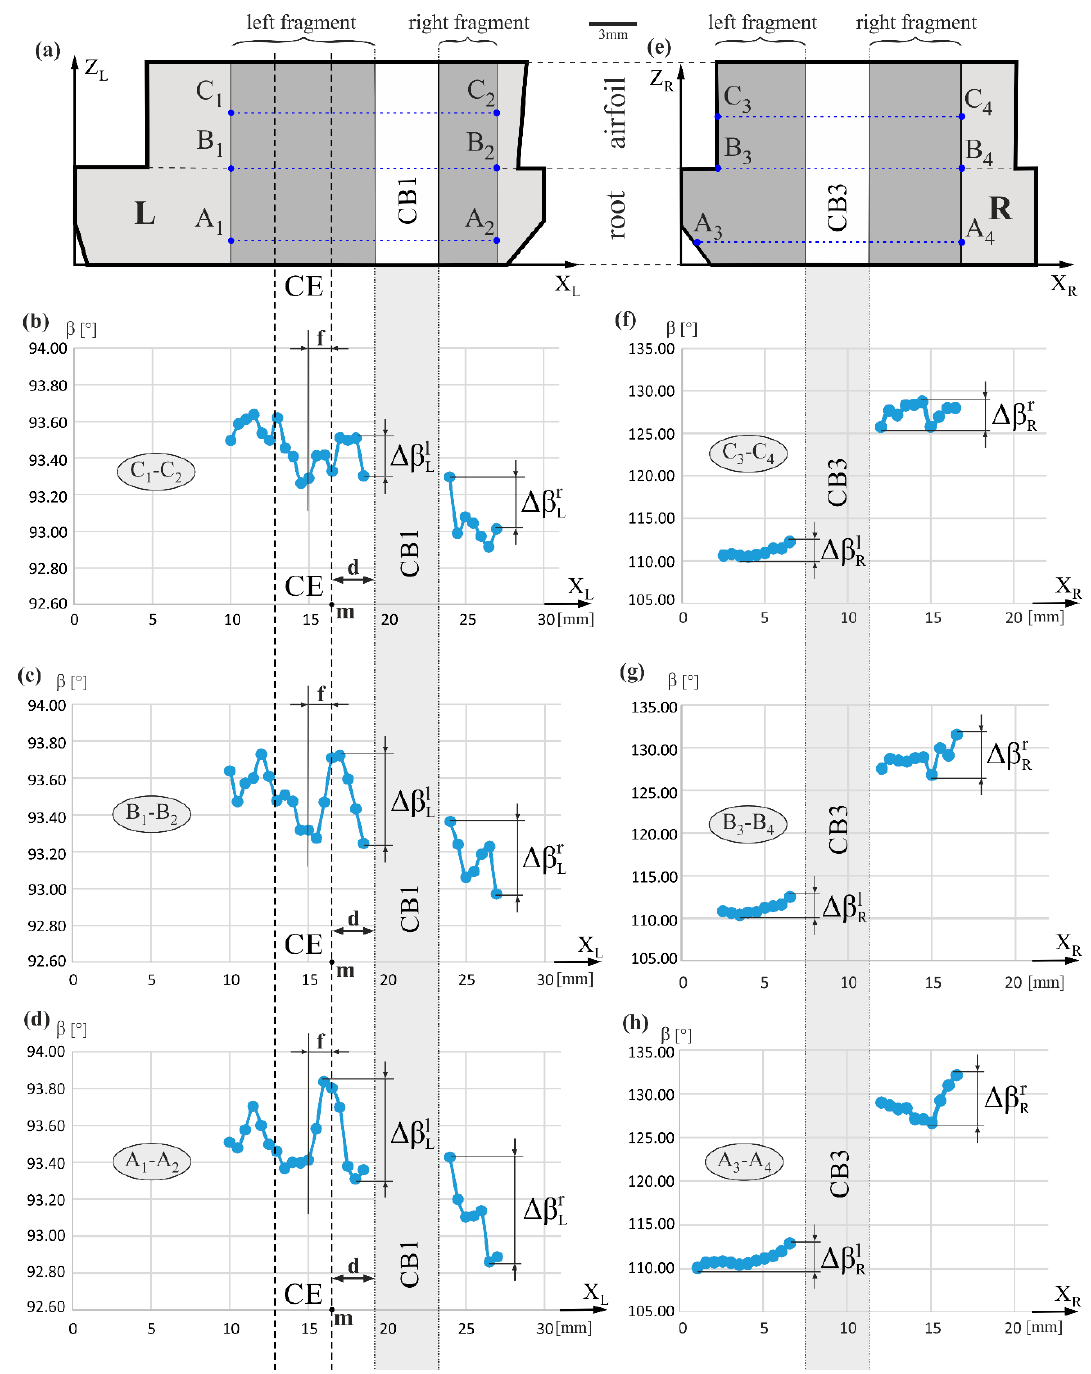
Figure 4. Schema of the arrangement of the β angle measurement lines ( a , e ), and the distribution of the β values on the fragments of the L ( b – d ) and R ( f – h ) surfaces along these lines in the vicinity of the cooling bores (CB1 and CB3). The labels of the measurement axes are replaced by parallel axes X L and X R for simplicity of analysis.